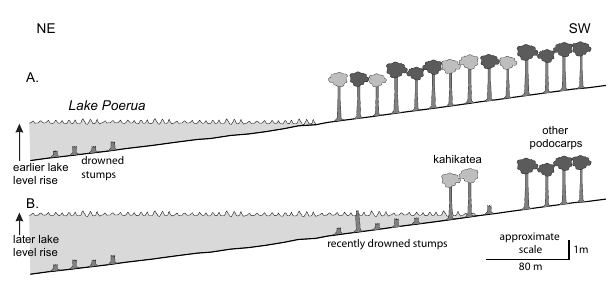
Fig. 5. Model of the relationship between fringing lowland for- est and lake level change at the southern end of Lake Poerua. (A) Drowned trees indicate an earlier lake level rise. (B) a sec- ond lake level rise kills off trees surrounding the lake shore. Some kahikatea trees near the lake shore may survive in shallow water near the new lake